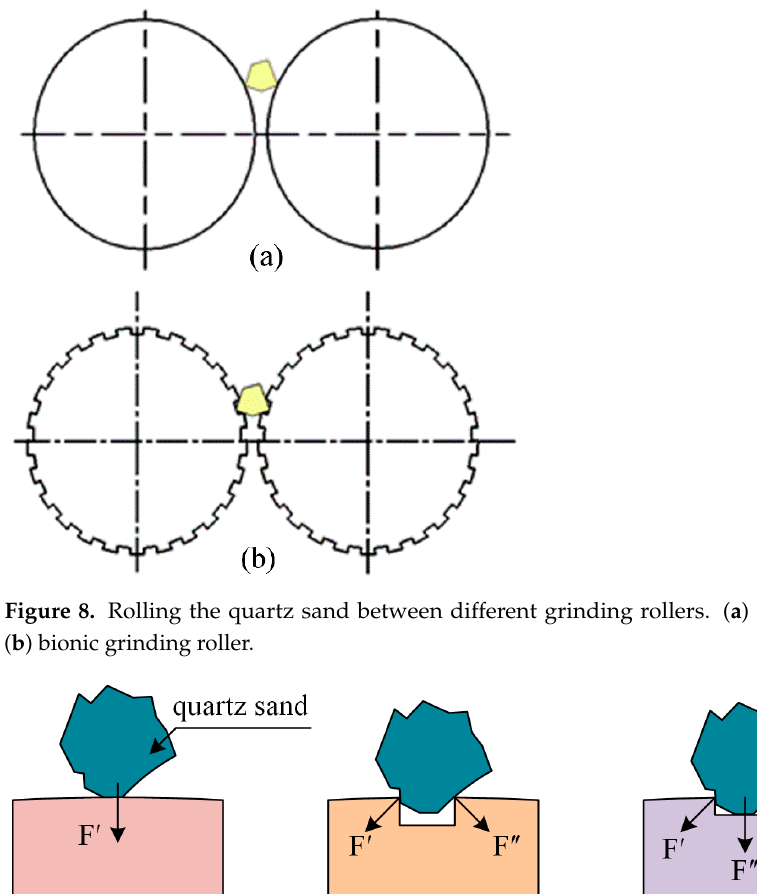
Figure 8. Rolling the quartz sand between different grinding rollers. ( a ) normal grinding roller ( b ) bionic grinding roller.